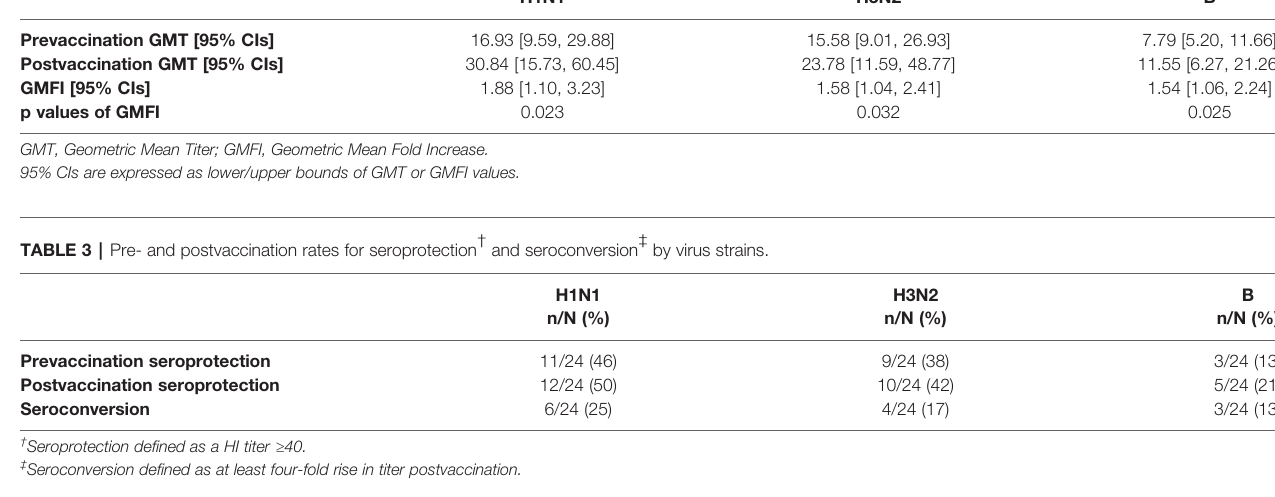
TABLE 2 | GMT and GMFI values on day 0 (prevaccination) and day 21-28 (postvaccination) according to virus strains.